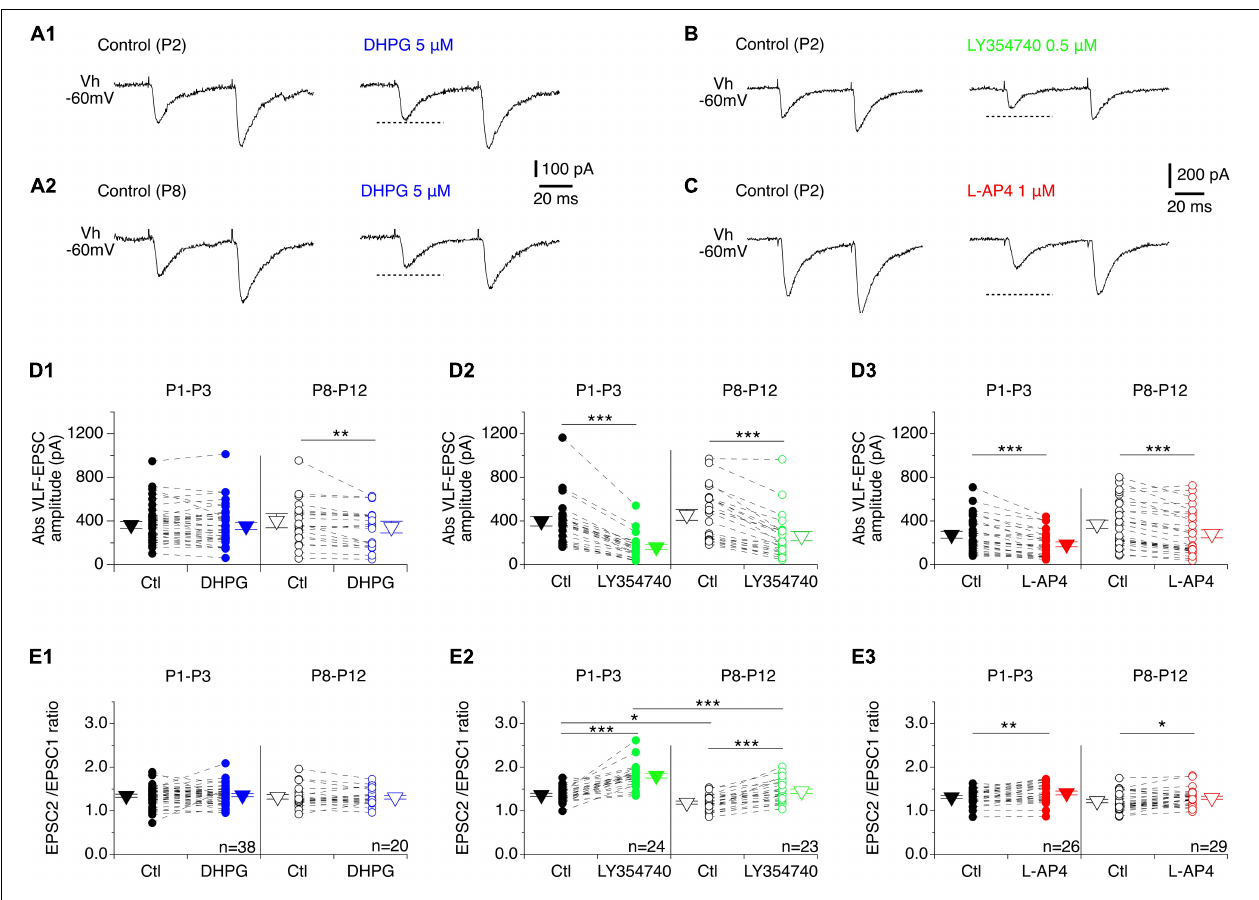
FIGURE 3 | Effects of mGluR agonists on VLF-MN synaptic transmission. (A) Representative traces of EPSCs induced by paired stimulations (50 ms interval) applied to VLF axons in lumbar MNs held at –60 mV (Vh –60 mV) in a P2 (A1) and a P8 (A2) mouse in control condition (left panels) and in the presence of DHPG (right panels). Note the absence of effect of DHPG in P2 MNs. (B) Sample traces recorded from a P2 lumbar MN during paired-pulse VLF stimulations showing the decrease in EPSC amplitude observed in the presence of LY354740 compared to control condition. (C) Same as in B for a P2 MN recorded in control condition and in the presence of L-AP4. (D) Scatter plots with connecting lines (dashed) of absolute VLF-EPSC amplitudes recorded in P1-P3 (filled circles) and P8-P12 MNs (open circles) before (black circles) and after exposure to DHPG (blue circles, D1 ), LY354740 (green circles, D2 ) or L-AP4 (red circles, D3 ). (E) Same data presentation as in (D) for mean EPSC2/EPSC1 ratios. DHPG was ineffective in affecting the EPSC2/EPSC1 ratio in both P1-P3 and P8-P12 MNs, while LY354740 and L-AP4 significantly increased it at both developmental stages tested. The triangles correspond to means ± sem of the population tested in each condition. Two-way RM ANOVA followed by Sidak’s post hoc tests, * p < 0.05; ** p < 0.01 and *** p < 0.001 significantly different.